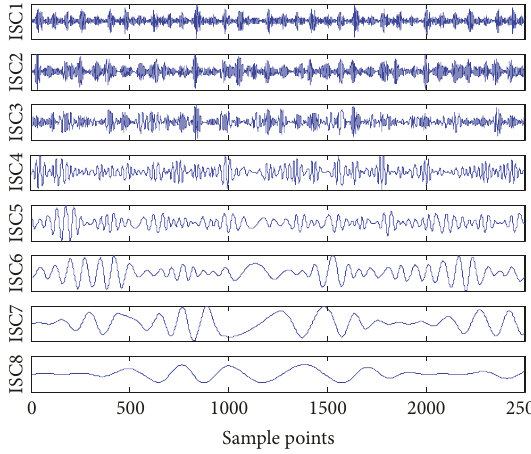
Figure 7: Inner race fault signal ELCD results.